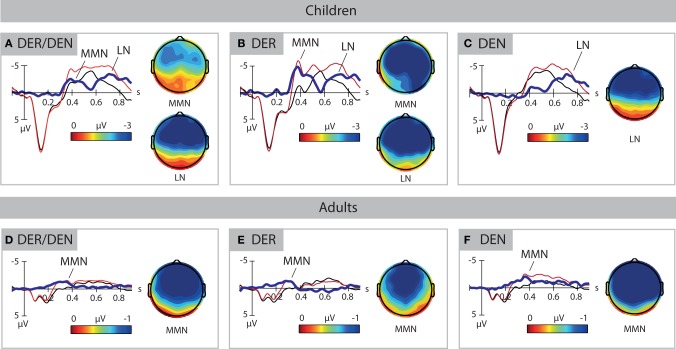
ERP response to standards (in black) and deviants (in red). Voltage topographies are calculated for peak amplitudes of deviant-minus-standard difference wave (in blue), as reported in Table 1. The upper panels show the data of the children, the lower panels show the data of the adults. (A,D) shows the data for all deviants. (B,E) shows the data for the high-frequency deviant DER. (C,F) shows the data for the low-frequency deviant DEN. Negativity is plotted upwards. MMN, mismatch negativity; LN, late negativity.